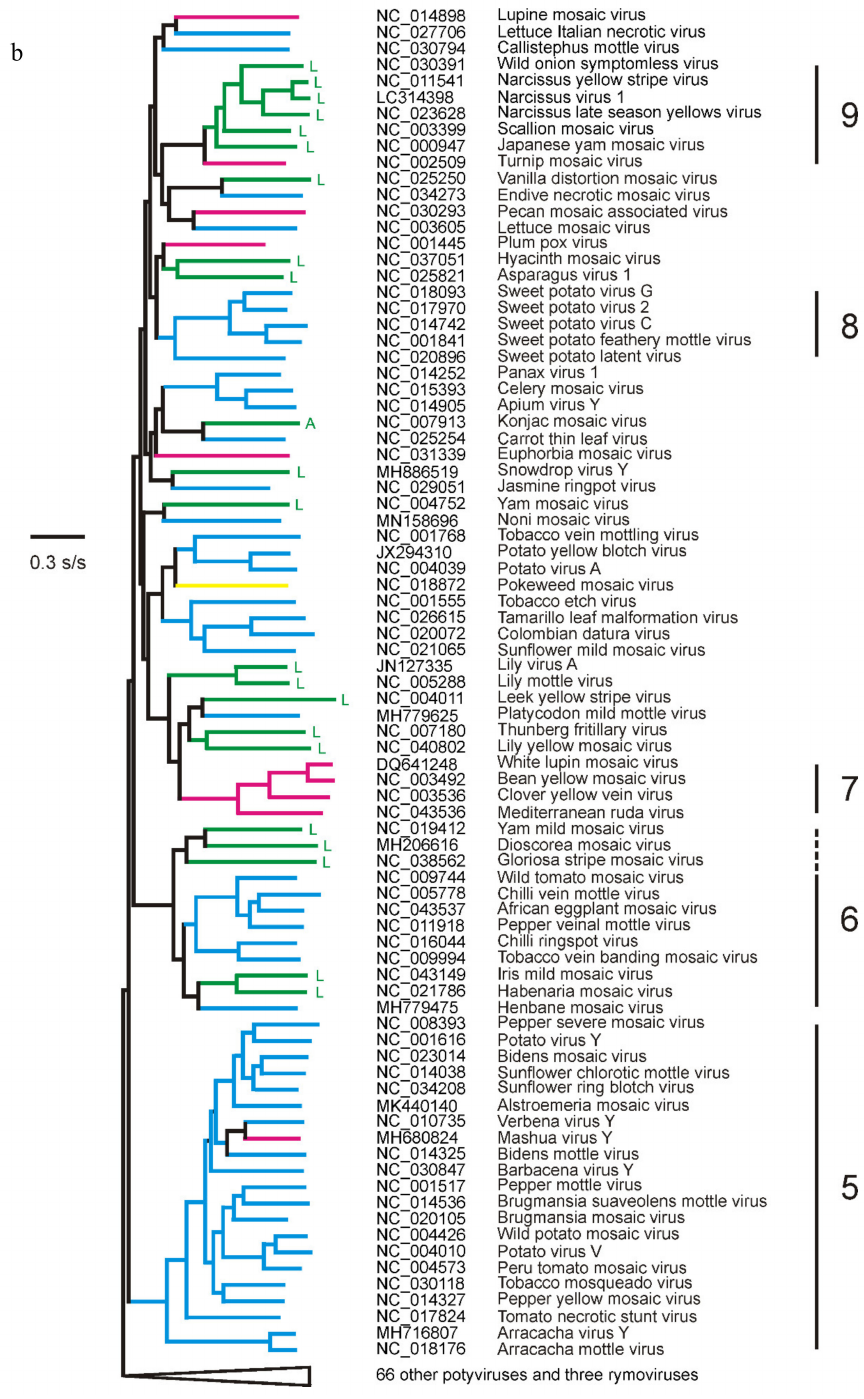
Figure 3. An ML phylogeny of 149 potyvirus ORF sequences with three rymovirus ORFs as outgroup using the same methods as [29–31]. The ORFs are from all 126 potyviruses represented in GenBank in mid-2019 by Reference Sequences, together with single representative sequences of all 23 other potyviruses in GenBank with unique names. Note that ( a ) shows the three rymoviruses and Lineages 1–4, whereas ( b ) shows Lineages 5–9. The “Order” of the primary host, namely the plant from which each was first isolated, and often given in the name of the virus, is shown by the branch color (and letter), eudicotyledonous rosid (red), asterid (blue), or caryophyllid (yellow) and